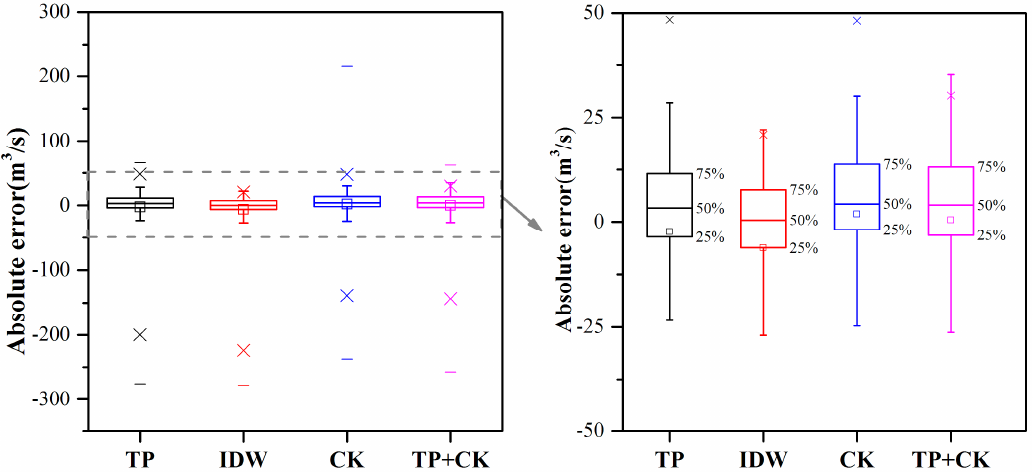
Figure 5. Box plots of absolute errors with different interpolation methods in 2012.